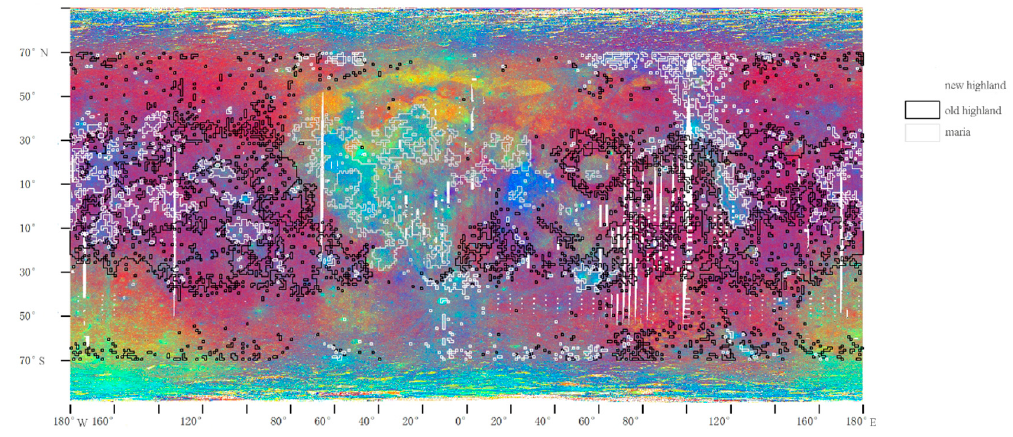
Figure 3. Global false color image mosaic with Clementine UV/VIS spectral data (R = 750/415 nm, G = 750/1000 nm, B = 415/750 nm, https://planetarymaps.usgs.gov) and the three areas.